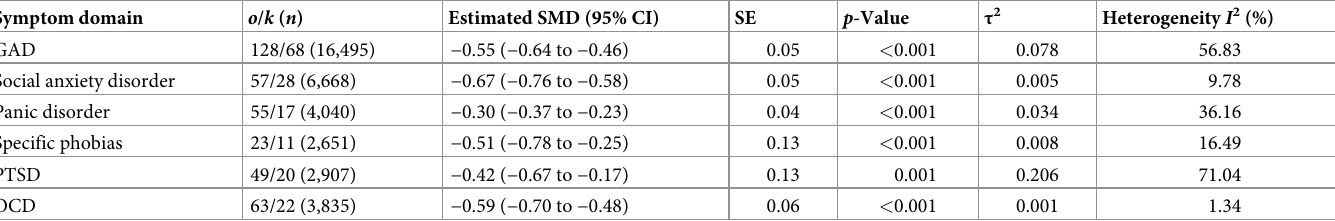
Table 2. SMD between medication (selective serotonin reuptake inhibitor or serotonin and norepinephrine reuptake inhibitor) and placebo for each symptom domain in the included studies. Symptom domain o / k ( n